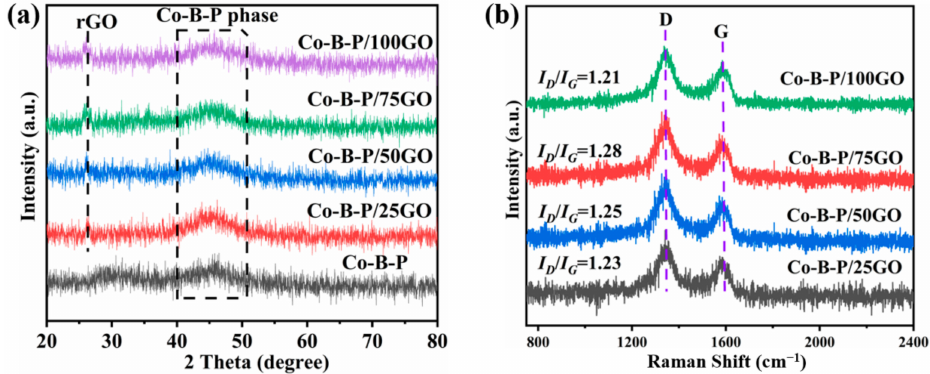
Figure 3. ( a ) XRD patterns of Co-B-P and Co-B-P/xrGO catalysts; ( b ) Raman spectra of Co-B-P/xrGO catalysts (x = 25, 50, 75, and